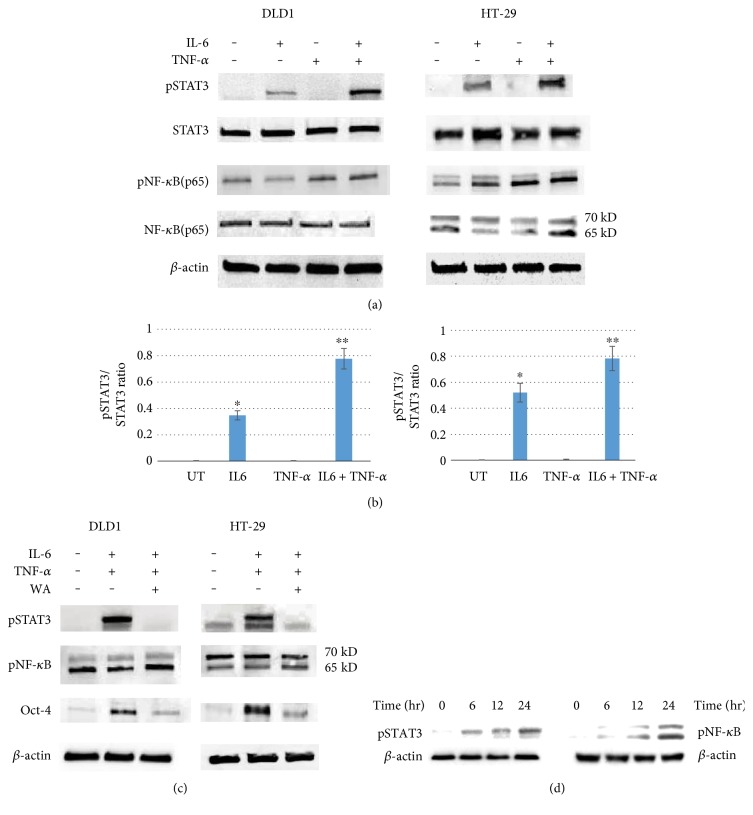
STAT3 was activated by IL-6 and TNF-α treatments whereas inhibited by withaferin A in human colorectal cancer cells. (a) Western blot analysis of DLD1 and HT-29 for pSTAT3, total STAT3, pNF-κB, and total NF-κB. Cells were treated with IL-6 (10 ng/ml) and TNF-α (25 ng/ml) alone and in combination for 24 hours, then subjected to protein analysis for pSTAT3, total STAT3, pNF-κB, and total NF-κB. (b) A quantitative graph of pSTAT3: STAT3 ratio was presented from DLD1 and HT-29 (∗p < 0.05, ∗∗p < 0.001). (c) Western blot analysis of DLD1 and HT-29 for pSTAT3, pNF-κB, and Oct-4. Cells were treated with either IL-6 (10 ng/ml) and TNF-α (25 ng/ml) alone or in combination for 24 hours. Withaferin A was treated at 10 μM concentrations for 24 hours as indicated. (d) STAT3 and NF-κB phosphorylation was measured with IL-6 and TNF-α stimulation on a time course. DLD1 cells were treated with combined IL-6 and TNF-α and monitored the phosphorylation status on different time points of 0, 6, 12, and 24 hours.